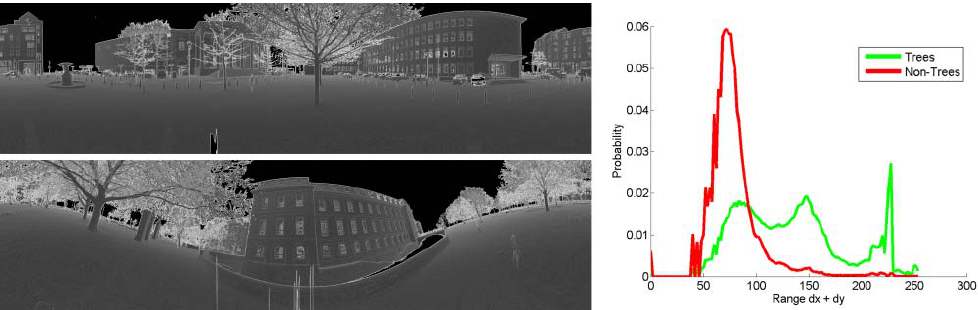
Figure 5. dx + dy values of the range channel, and their tree/non-tree distribution.